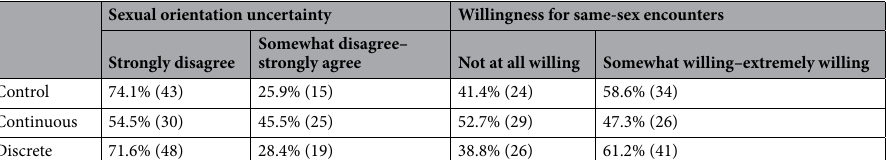
Sexual orientation